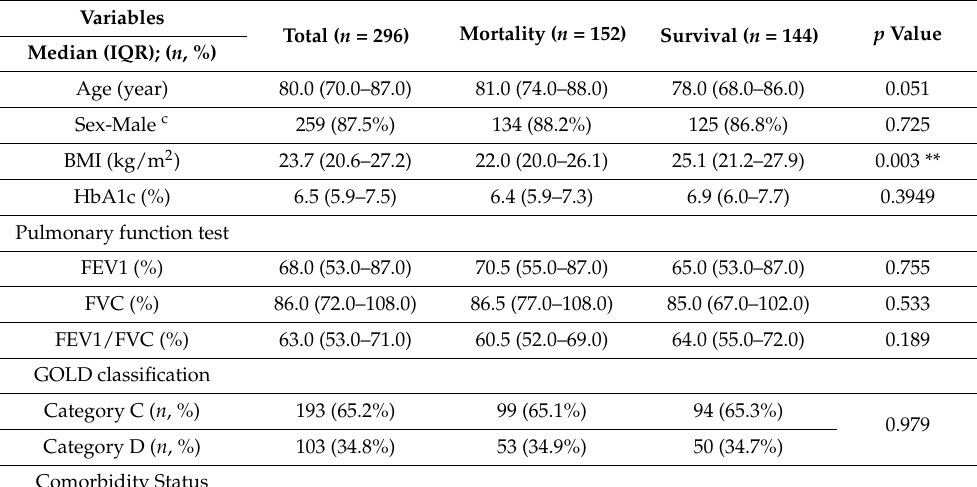
Table 2. Factors associated with overall mortality with median 3-year follow-up time of aged COPD patients required hospitalization ( n =